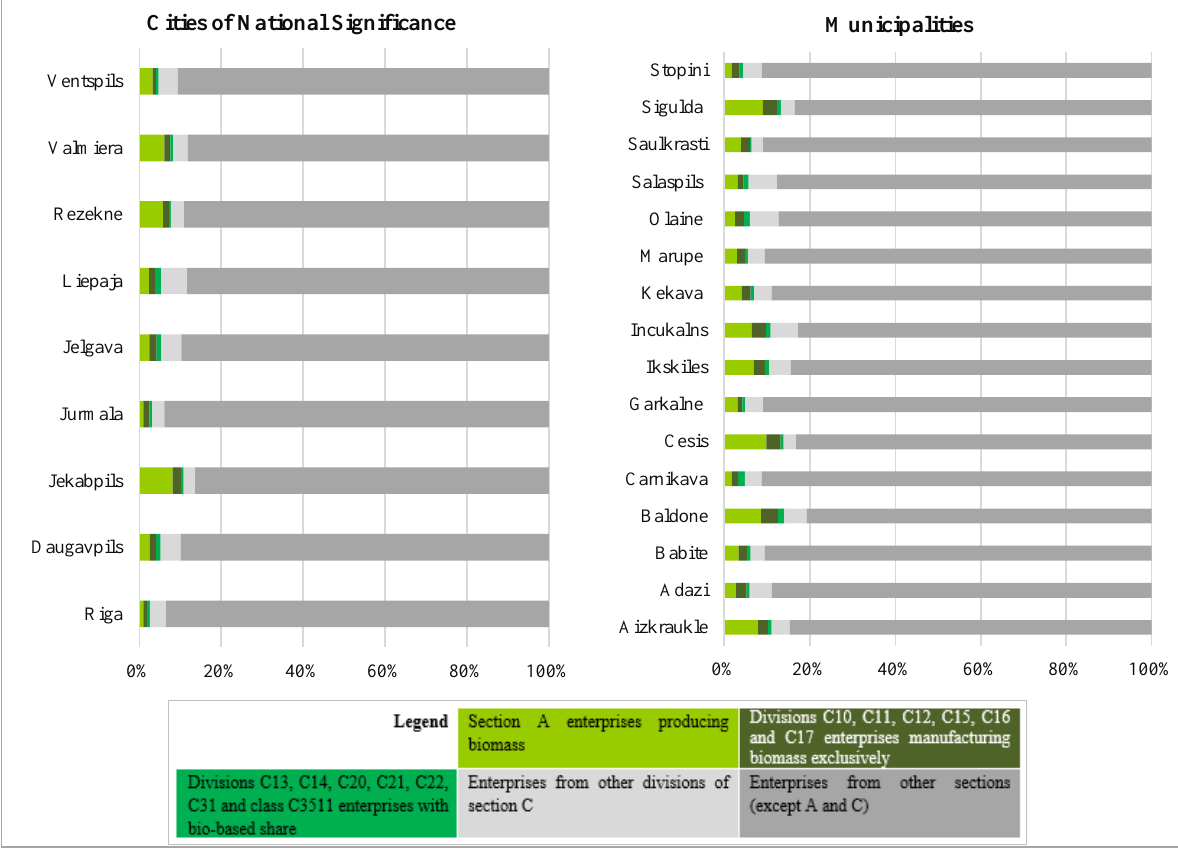
Figure 6. Distribution of divisions (according to the NACE Rev. 2 classification) by number of economically active enterprises of the market sector in the municipalities belonging to Group C in 2019,